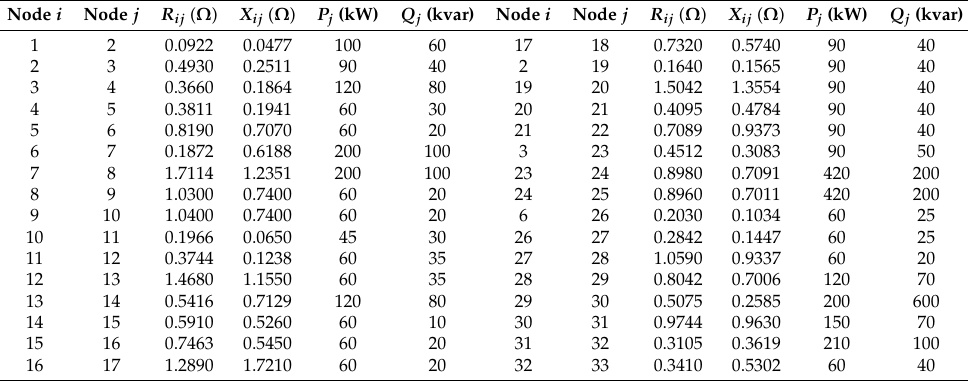
Figure 2. Nodal connections between nodes in the IEEE 33-bus grid with load classifications. Table 2. Load and distribution line parameters of the IEEE 33-bus grid.